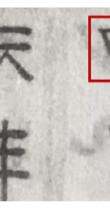
Figure 1. Example of Shui manuscript characters.